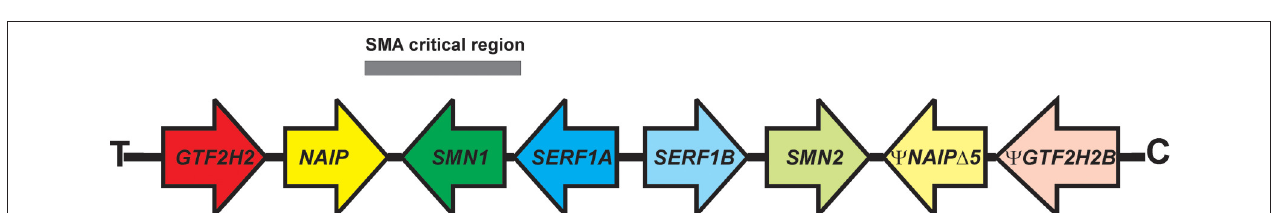
10% of the mRNAs from SMN2 contain exon 7 and these full- length mRNAs can produce some full-length, functional SMN